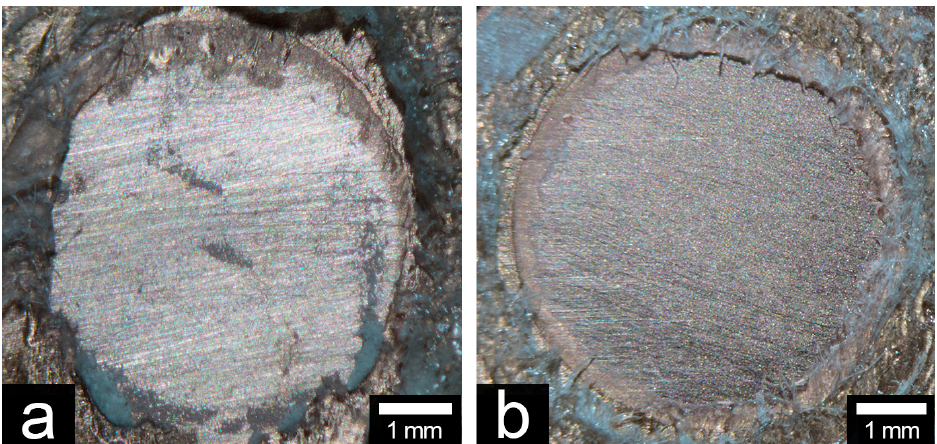
Figure 2. The representative debonded surfaces of coppers: ( a ) combination of adhesive and cohesive failures (CA, UH–MTU-6 group); ( b ) adhesive failure at the acrylic resin–metal interface (A, UH–unprimed group). Digital photographic system: original magnification ×8.